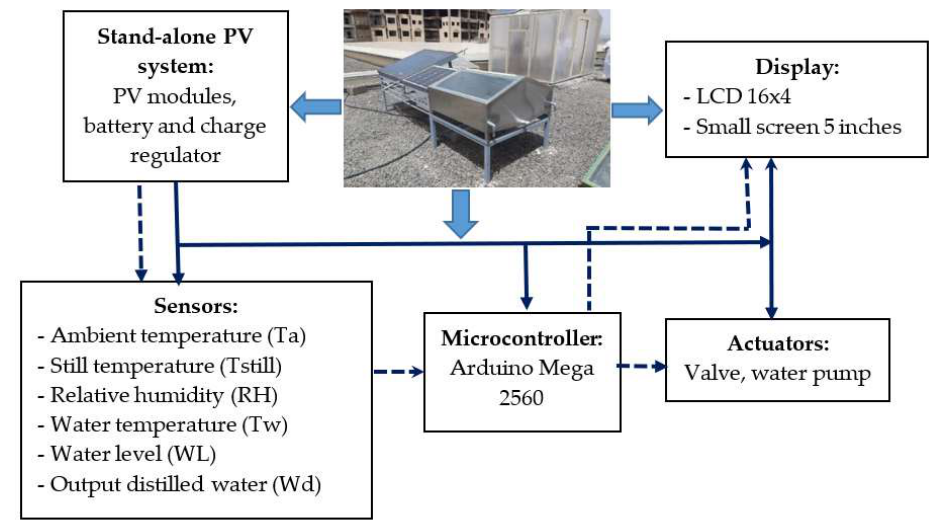
Figure 3. Basic structure of the monitoring system (solid line: power, dashed line: data).